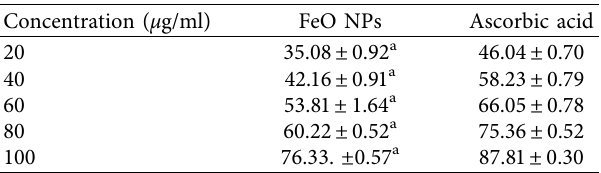
Figure 3: SEM images of synthesized Iron oxide nanoparticles at (a) 20 μ m, (b) 30 μ m, (c) 80 μ m and (d) 100 μ m respectively. Table 1: DPPH radical scavenging activity of iron oxide nano- particles (%